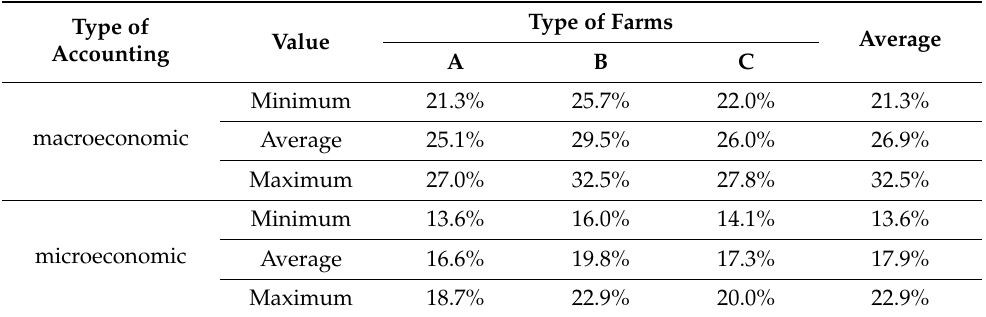
Table 1. Statistical values of the internal rate of return from investment in macro- and microeconomic accounting depending on the farm